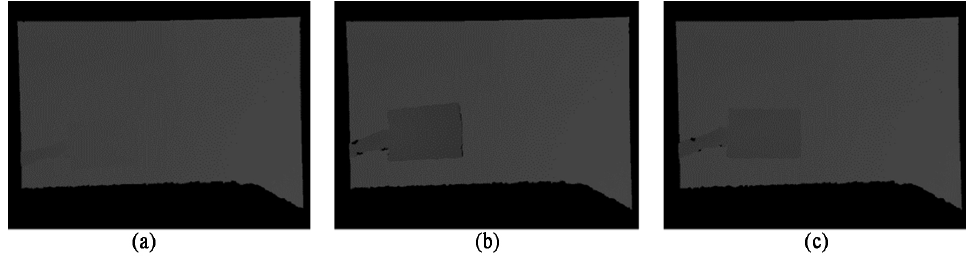
Figure 8. Color sampling map of Experimental Scenario One: ( a ) the 74th frame; ( b ) the 94th frame; ( c ) the 134th frame.